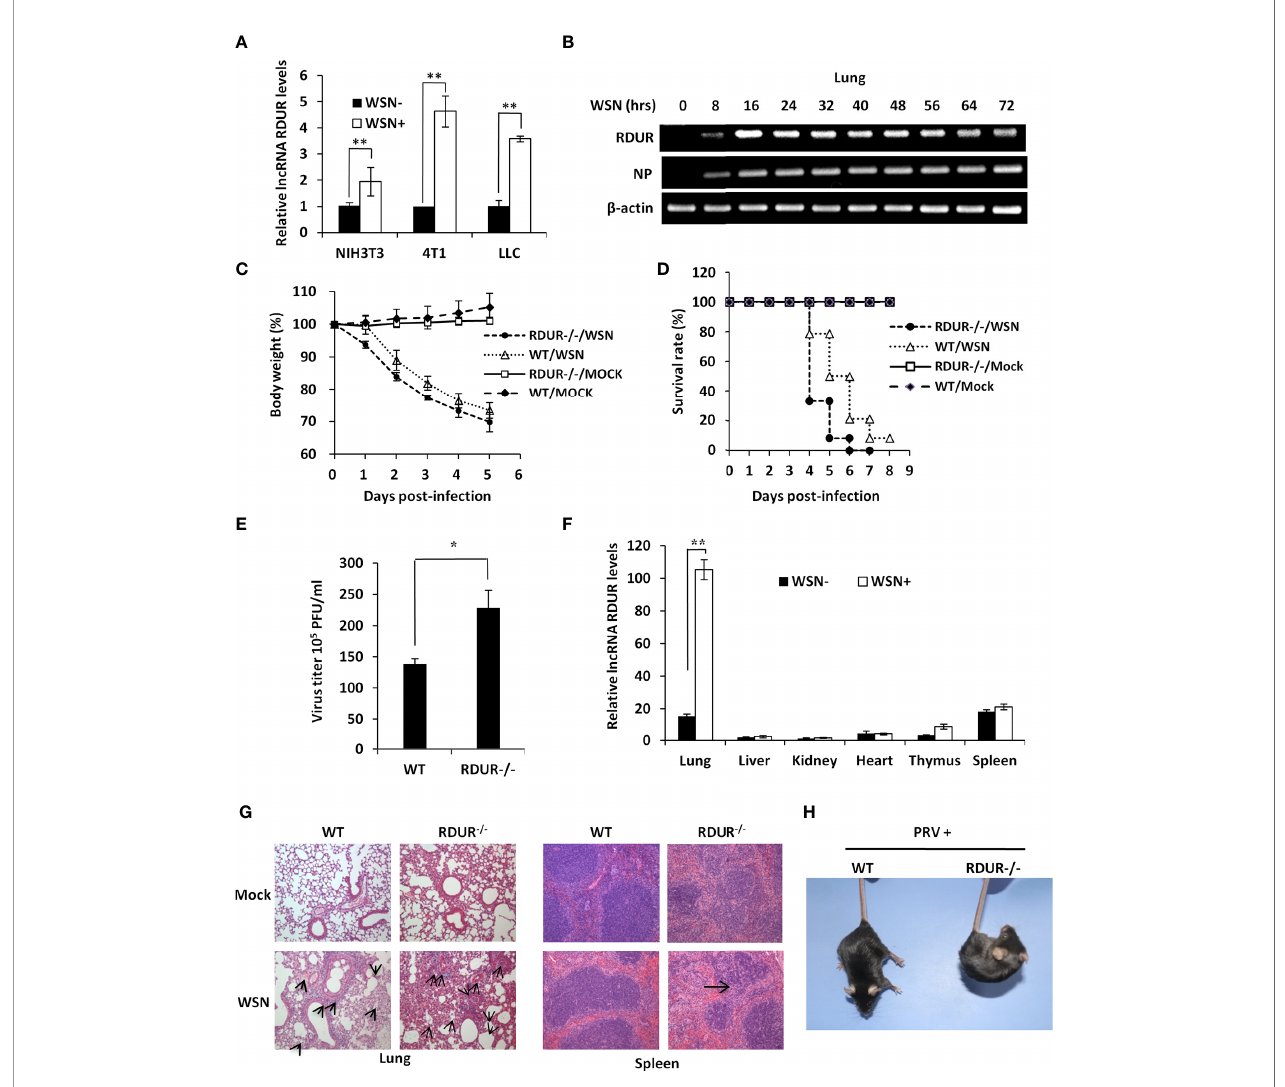
FIGURE 5 | mRDUR-de fi cient mice are more susceptible to IAV and PRV infections. (A) The expression of mRDUR in three mouse cell lines infected with or without WSN for 16 h was examined by qRT-PCR. The error bars represent the SD, ** P < 0.01, * P < 0.05. (B) The mRDUR expression levels in the lungs of mice infected with or without WSN for 0-72 h were examined by RT-PCR. (C, D) Shown are the body weight change and survival rates of mRDUR knockout and control mice intranasally inoculated with WSN or Mock. Body weight was measured every day (8 mice for each Mock group and 14 mice for each WSN infection group). (E) Viral titers in the lungs of mRDUR knockout and control mice inoculated intranasally with WSN for 72 h were measured by plaque assay. Plotted are the average levels from three independent experiments. The error bars represent the SD, * P < 0.05. (F) Expression levels of mRDUR in different organs (lung, liver, kidney, heart, thymus and spleen) of mice infected with WSN or Mock were examined by qRT-PCR (n = 3; means ± SD; ** P < 0.01). (G) Shown are representative micrographs of H&E stained lung (left) and spleen (right) sections of the mRDUR knockout and control mice infected with or without WSN. (H) WT and RUUR-/- mice were intramuscularly infected with PRV for 2 days, and shown is representative clinic-pathological phenotype from three independent